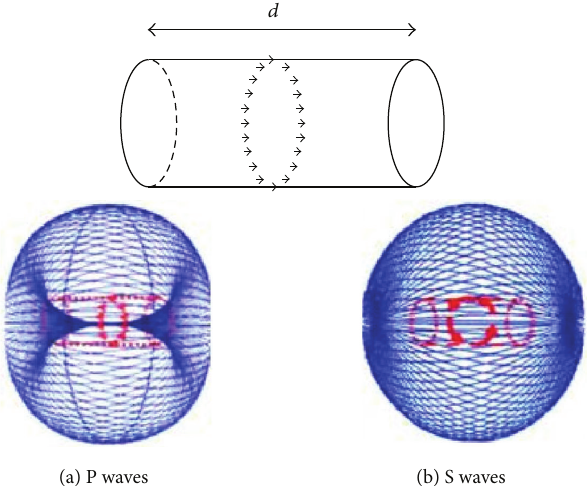
Figure 10: Propagation of waves created by tangential stress applied to alveole